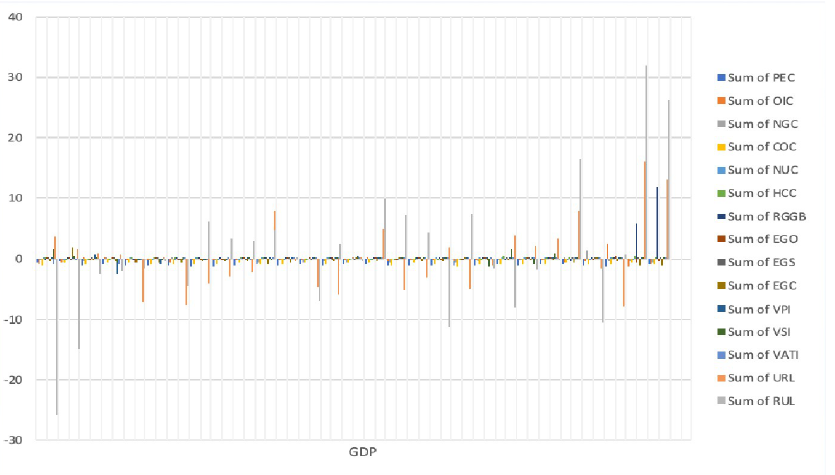
Fig 10. Pivot chart with